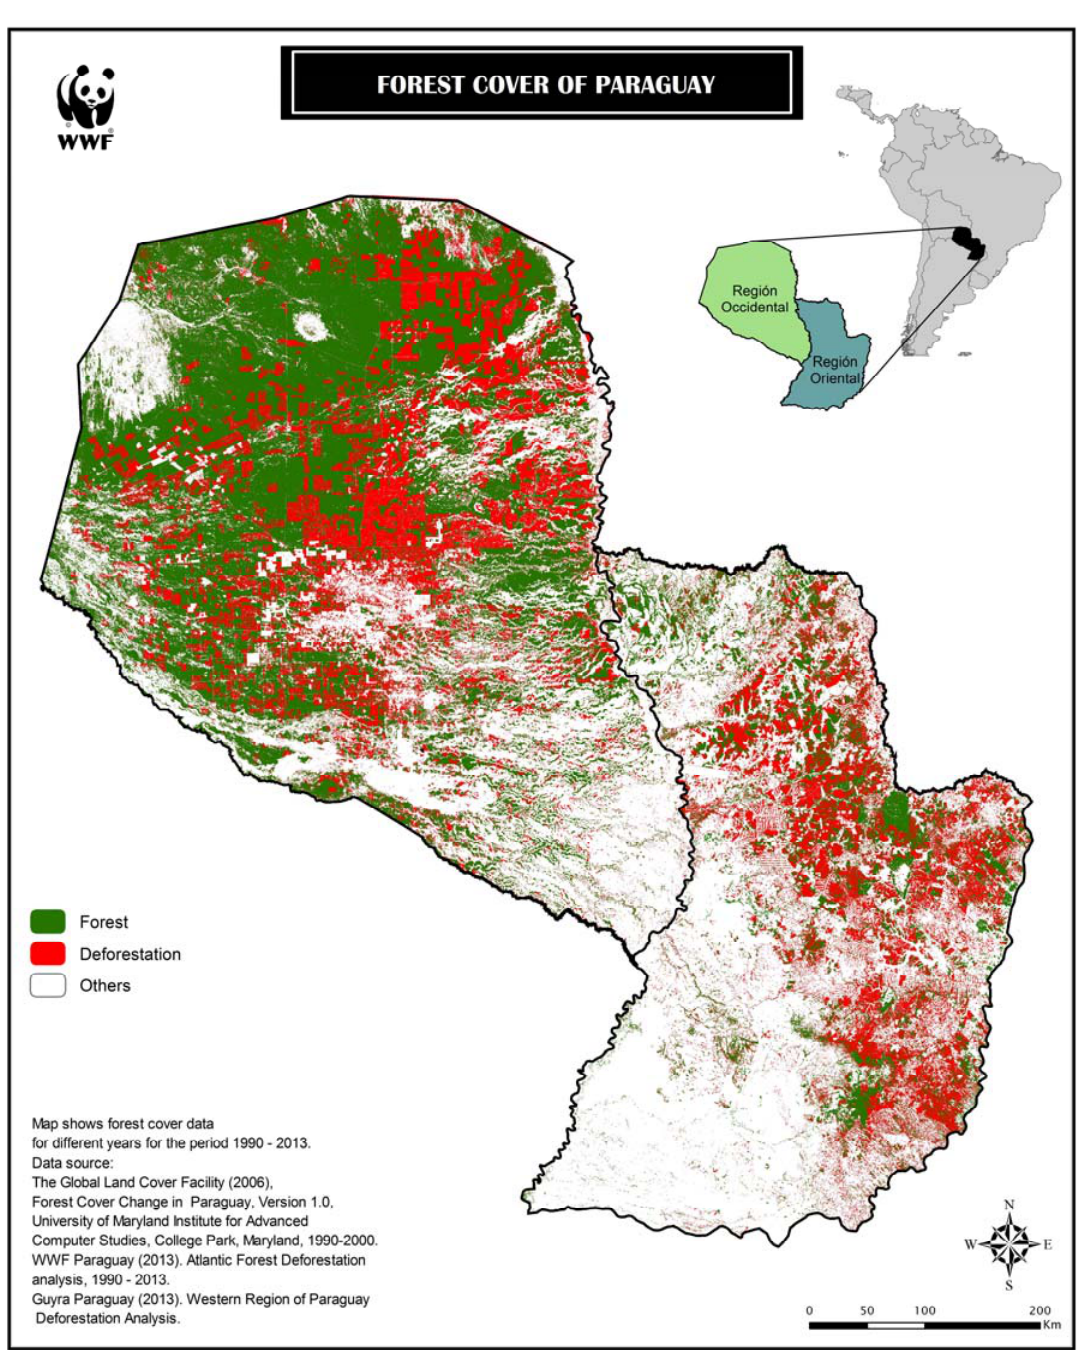
Figure 2. Forest cover of Paraguay and